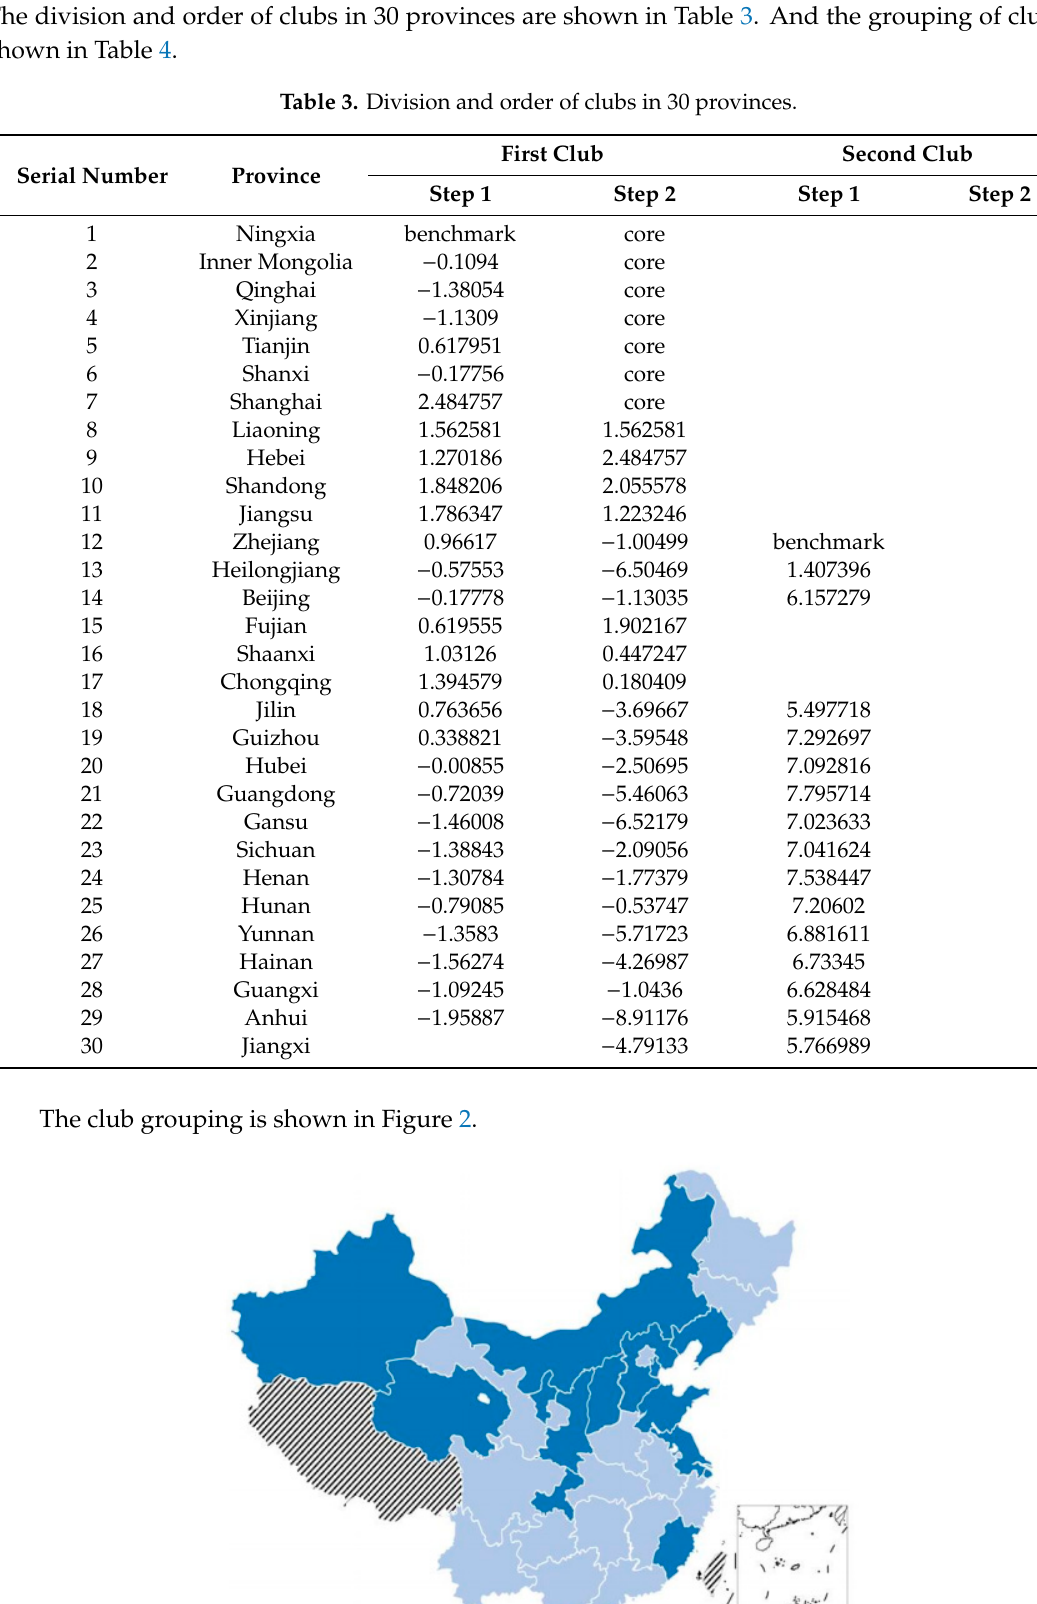
Table 5. Results of regional convergence test in clubs. Test Parameters